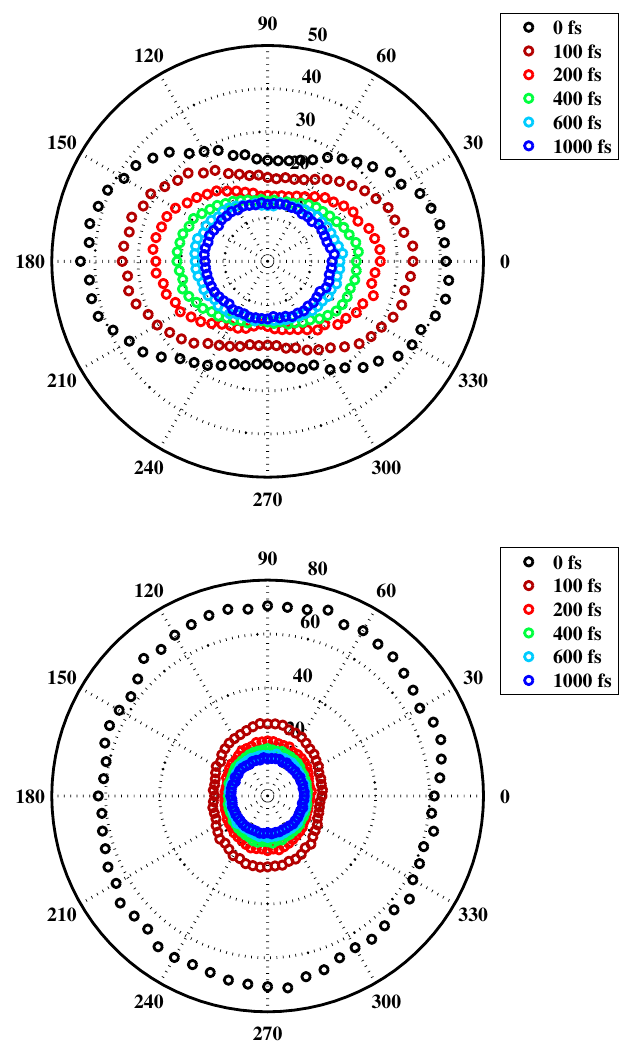
FIG. 5. Pump-probe ion yield vs pump polarization and pump- probe delay. Top panel: For 42 amu. Bottom panel: For the parent ion. The azimuth angle corresponds to the relative polar- ization between the pump and the probe beams, while the radial distance is proportional to the ion yield in arbitrary units. Both the parent ion and 42 amu show a decay in the yield with increasing pump-probe